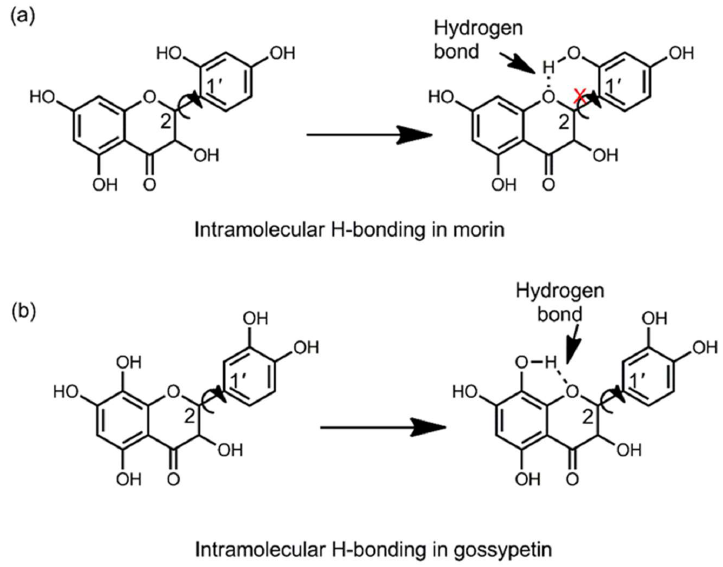
Figure 6. Possibility of intramolecular H-bonding in morin can restrict the free rotation of the cin- namoyl and benzoyl moieties around C1′-C2 single bond ( a ) while such contribution in gossypetin cinnamoyl and benzoyl moieties around C1 (cid:48) -C2 single bond ( a ) while such contribution in gossypetin is not feasible ( b ). is not feasible ( b